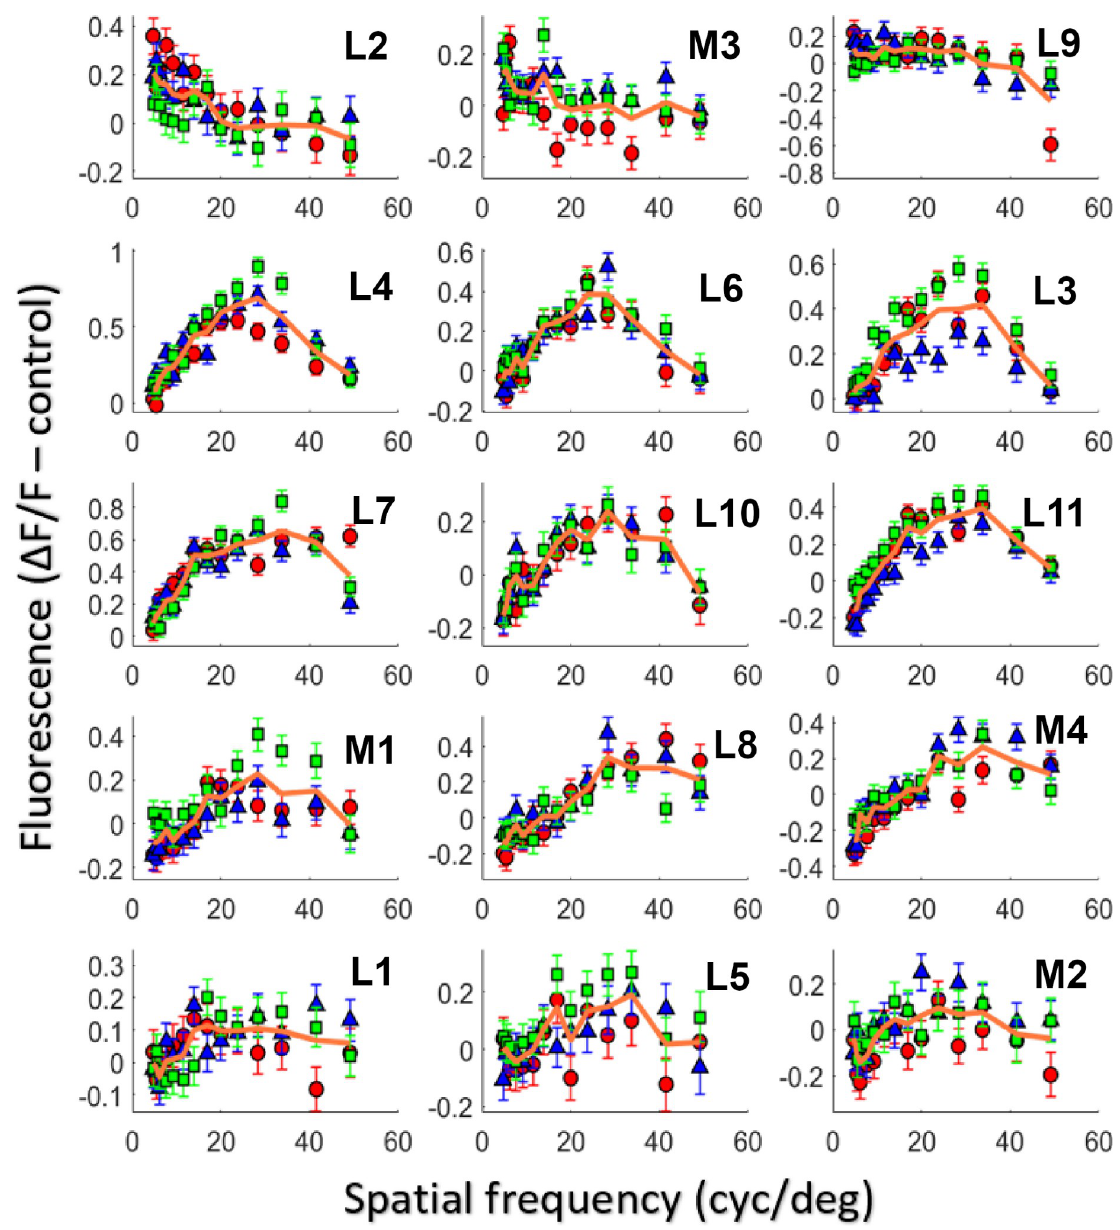
Fig 5. Spatial frequency responses of putative midget cells. Fifteen cells in M3 serving the central foveal cones were identified as L-M or M-L opponent (Fig 3D). Each cell is numbered L1-11 or M1-4 based on whether the suspected center cone was an L or M cone. The red points (circles, Week 1), blue points (triangles, Week 2), and green points (squares, Week 3) are measurements from three different experiments each one week apart. The solid orange line in each panel is the average response for that particular cell across all three experiments. The vertical axis is a response metric where the mean baseline fluorescence is subtracted from the fluorescence under stimulation and divided by the fluorescence under stimulation at the peak spatial frequency (see Methods). The error bars show the standard error at each data point, which represents the error in obtaining the signal and background needed to calculate the metric. Additional spatial frequency responses of cells from the large imaging FOV (S5 Fig) and non-midget RGCs (S6 Fig) can be found in the